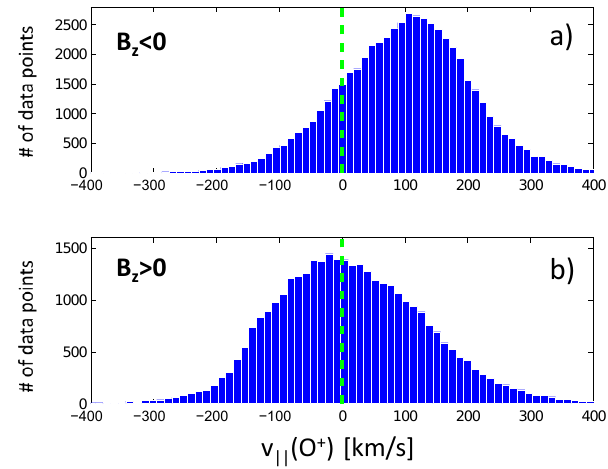
Figure 3. Histograms of the distribution of O + parallel bulk veloc- ities for southward IMF (a) and northward IMF (b)